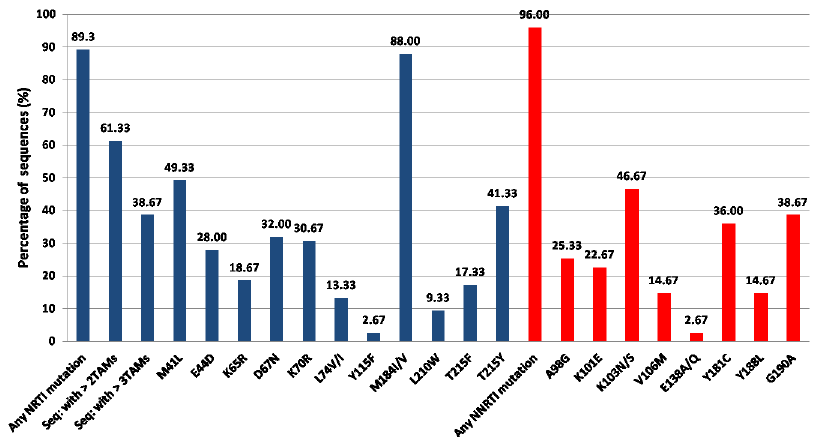
Fig 2. HIV drug resistance pattern. Pattern of NRTI and NNRTI drug resistancemutations following immunological failure. Abbreviations: NRTI—nucleoside/nucleotide analoguereverse transcriptase inhibitor, NNRTI—non-nucleosidereverse transcriptase inhibitor.